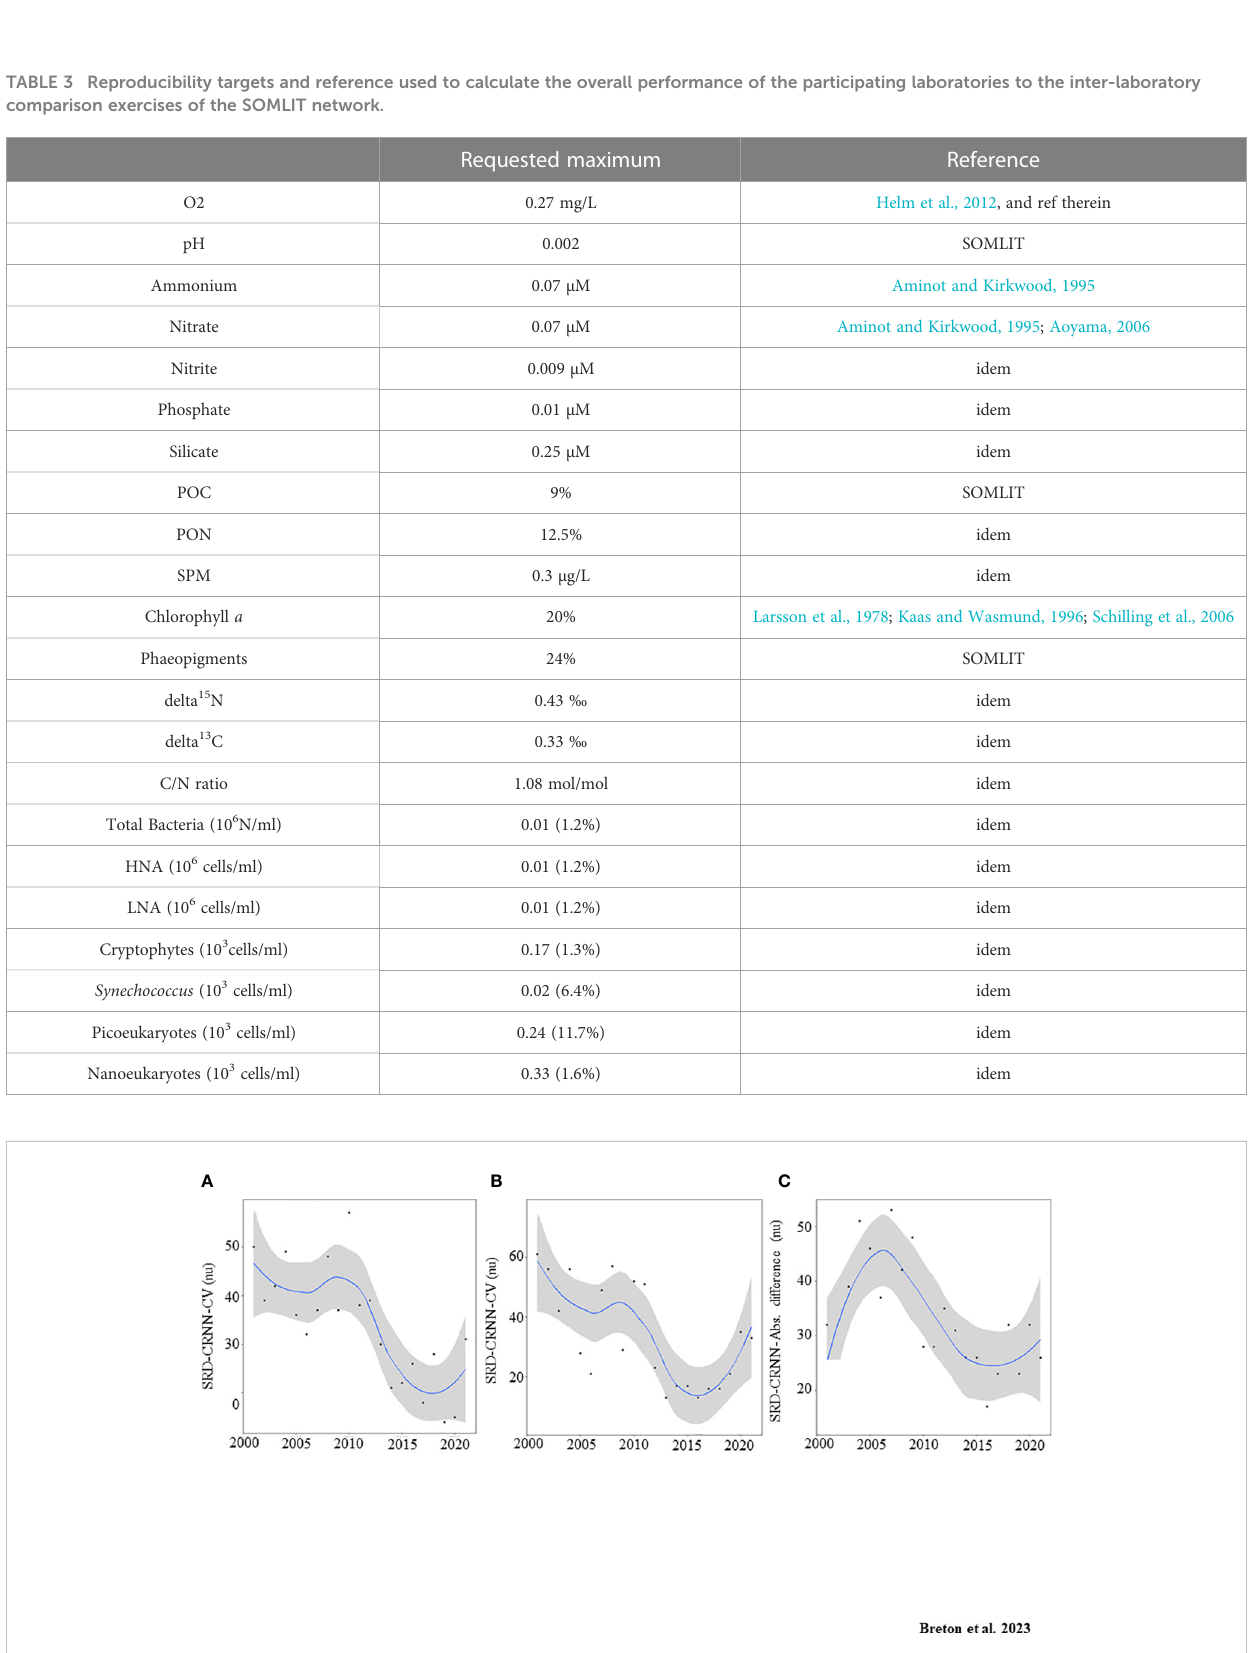
FIGURE 7 Long-term variations in (A) within-laboratory reproducibility (SRD-CRNN-CV, %), (B) between-laboratory reproducibility (the opposite of the robust coef fi cient of variation; SRD-CRNN-CV, %), and (C) trueness (bias measured as absolute difference between the inter-laboratory median value and the robust mean; SRD-CRNN-Abs. difference, nu) obtained during the inter-laboratory comparison exercises of the SOMLIT network over the period 2001 – 2021. The solid blue line and ribbon represent Locally Estimated Scatterplot Smoothing (LOESS) smoothing and the 95% con fi dence interval. SRD-CRNN, sum of ranking differences and comparison of ranks by random numbers; CV, coef fi cient of variation; nu, no unit.